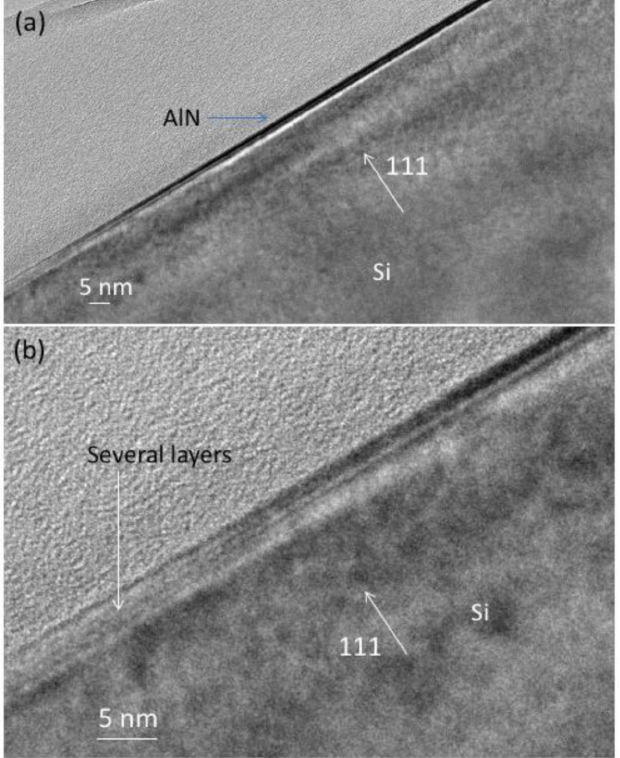
Figure 1. ( a ) TEM image showing AlN film on Si (111). ( b ) A higher magnification multibeam image showing the AlN film consisting of several